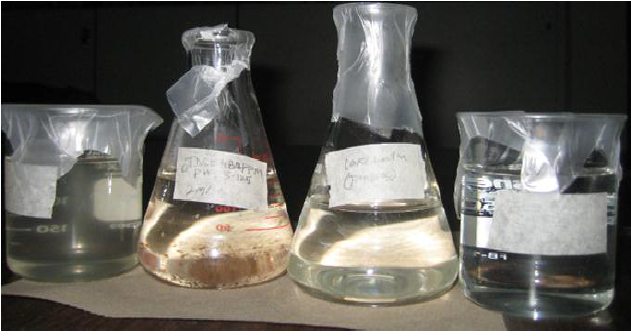
Figure 4. Lake water treatment processes, from left: untreated lake water, Tanfloc coagulation treatment (settlement), direct filtration, and coagulation/filtration.